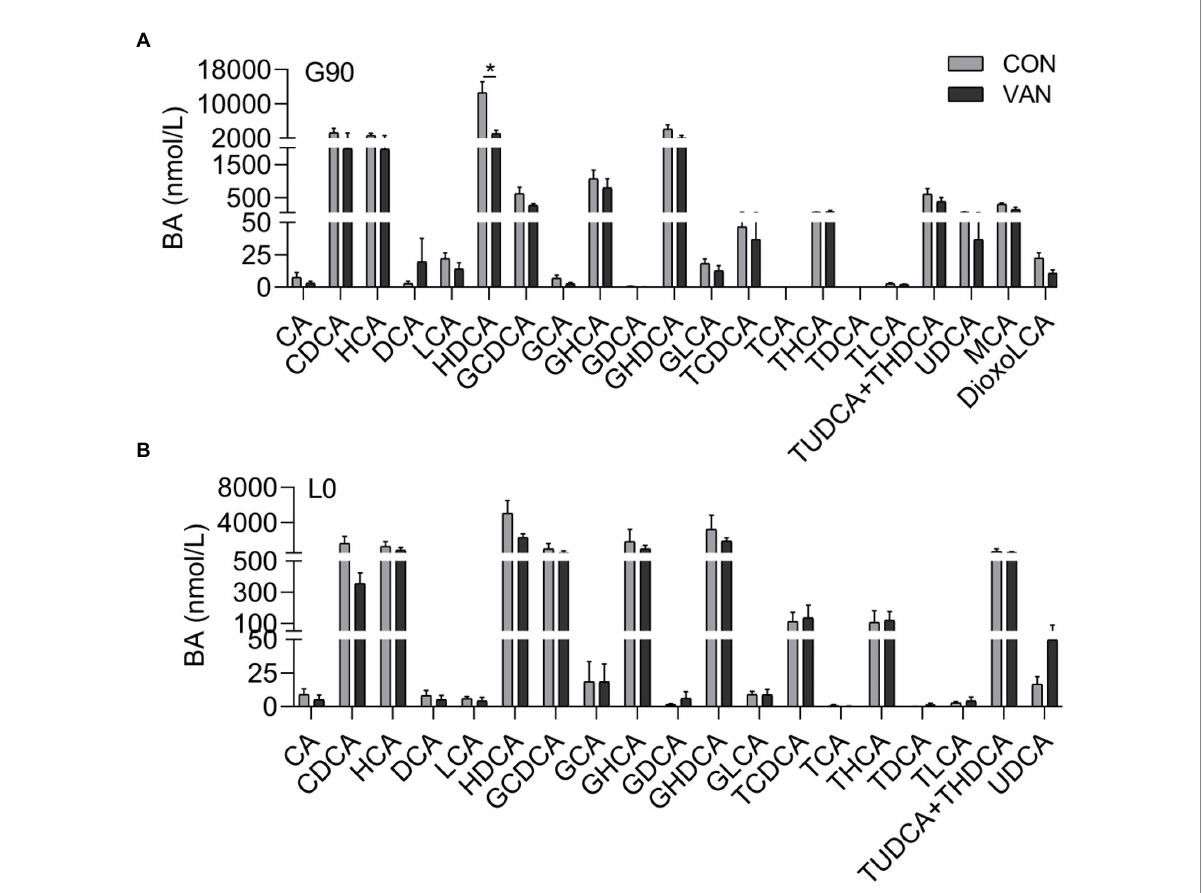
FIGURE 3 Comparison of serum BA profile between CON and VAN at (A) G90, and (B) L0, respectively. Data are shown as means ± SE, * p <